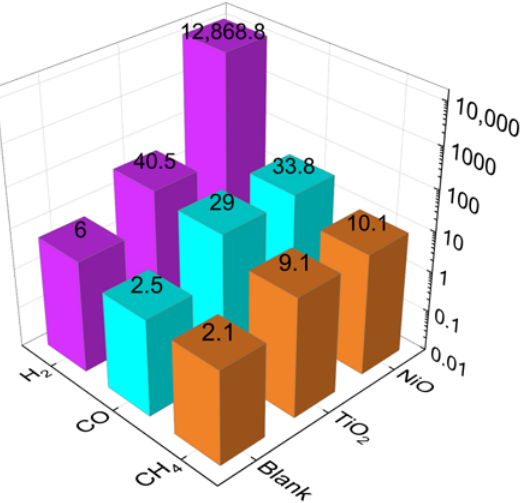
Figure 3. The production of flammable gases from H 2 O and CO 2 enclosed in a glass reactor after 24 h of magnetic stirring using a Teflon magnetic rotary disk for three cases: with no particles, with 1.00 g of TiO 2 nanoparticles, and with 1.0 g of NiO particles in the reactor, separately.